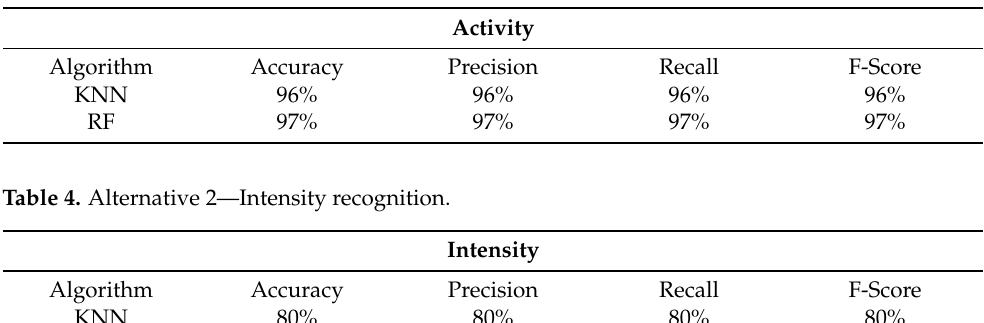
Table 3. Alternative 2—Activity recognition.